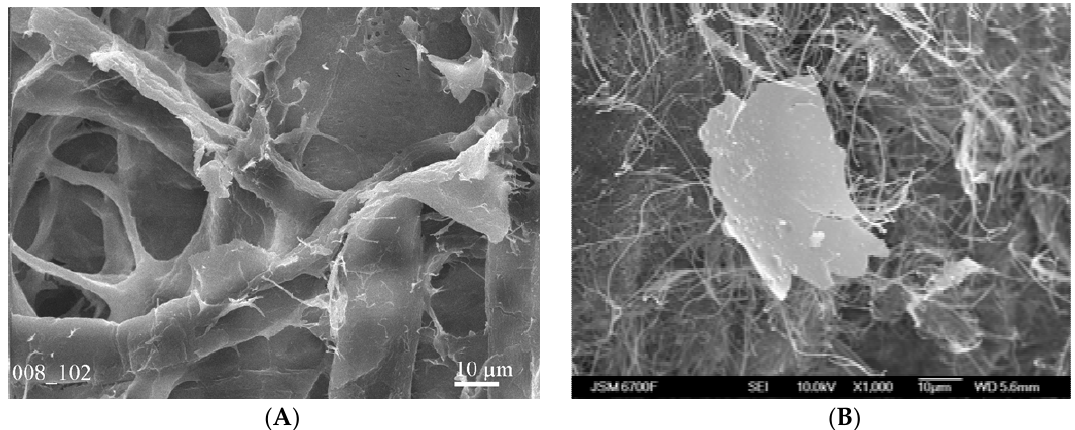
Figure 1. SEM images: Cu–carboxymethylcellulose grafted on cellulose fibers with activated carbon ( A ), Al(OH) 3 particles among chrysotile fibers ( B ). The marks on the SEM images ( A , B ) are 10 micrometers.